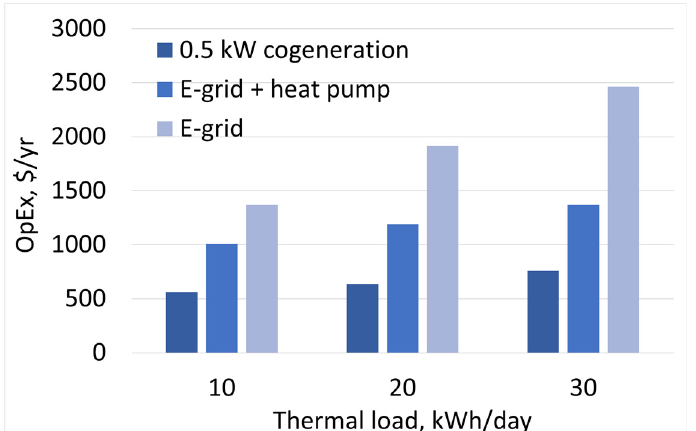
Figure 9. Annual operational expenditure of different system configurations with variable thermal loads: 0.5 kW cogeneration system at 40% electrical efficiency (2 kWh EES), heat pump with COP 3.0, and baseline electrical grid supported heating system (COP = 1.0); 15 kWh/day of electrical load, no PV.